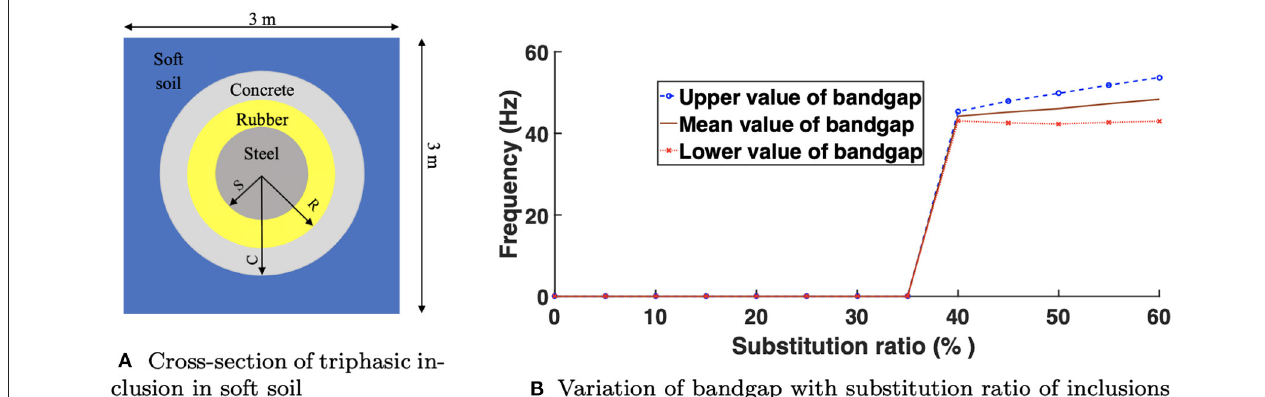
FIGURE 5 | Unclamped configuration (all three type of inclusion, i.e., concrete, rubber, and steel), and the variation of bandgap width vs. substitution ratio of triphasic inclusion in soft soil. The ratio of radius of each inclusion material for different substitution ratio is kept same, i.e., S steel, rubber, and concrete, respectively. The dimension of unit cell is 3 × 3 × 10 m, and properties of soft soil is taken as E = 96.5 MPa, µ = 0.33, and ρ = 1,650 kg / m 3 . (A) Cross-section of triphasic inclusion in soft soil. (B) Variation of bandgap with substitution ratio of inclusions.